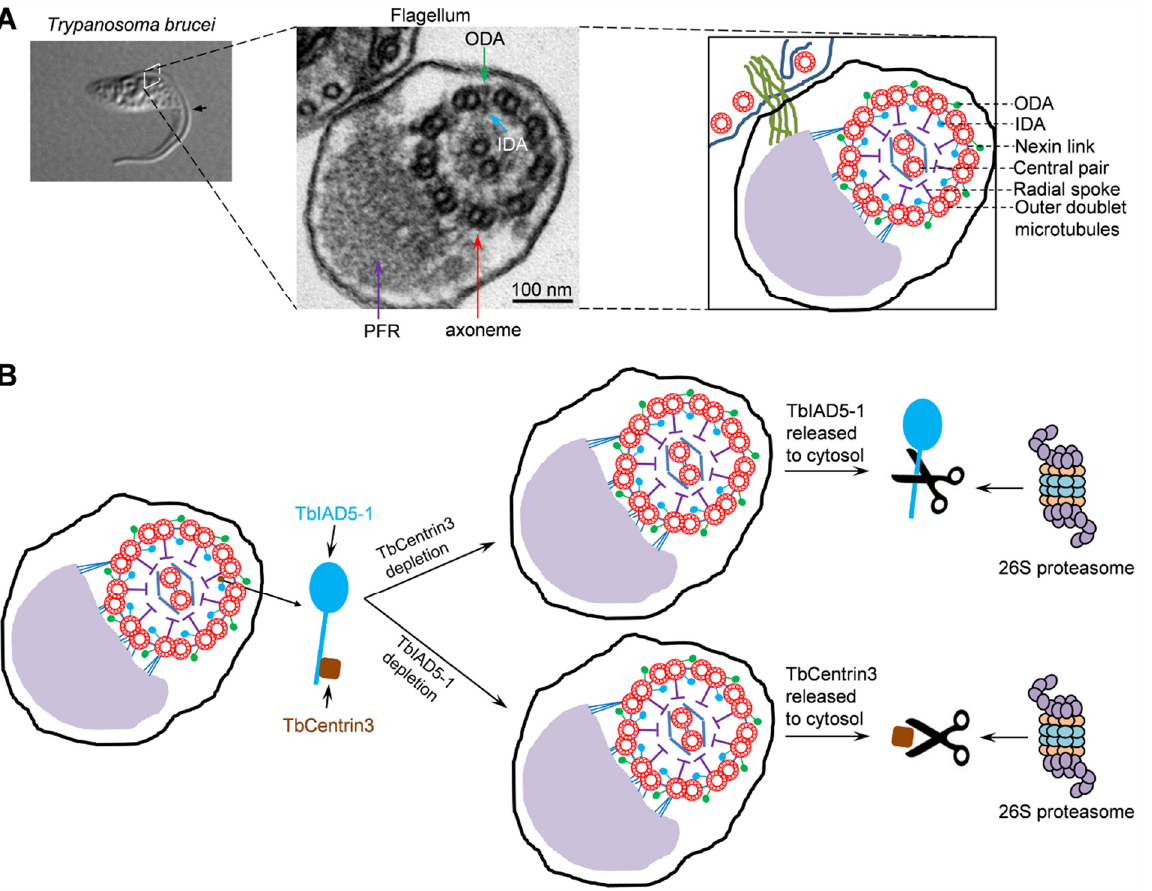
FIGURE 1: Role of TbCentrin3 in flagellar motility in trypanosomes. (A) The trypanosome flagellum and its axoneme structure. Shown on the left panel is a differential interference contrast (DIC) image of a procyclic cell of T. brucei with a single flagellum (arrow). The middle panel shows the transmission electron microscopy of a cross-section of the flagellum and the cell body to which the flagellum is attached. The paraflagellar rod (PFR), the axoneme, outer dynein arm (ODA), and inner dynein arm (IDA) are indicated. The right panel is a schematic representation of the micrograph shown in the middle panel. (B) Effect of TbCentrin3 depletion on the assembly and stability of TbIAD5-1 and vice versa. Note that only one IDA is labeled as the TbIAD5-1 - TbCentrin3 complex and that TbCentrin3 and TbIAD5-1 are not drawn to the same scale. The precise numbers of inner dynein arms containing TbCentrin3 and TbIAD5-1 are still unclear. In the absence of TbCen- trin3, newly synthesized TbIAD5-1 is not assembled to the axoneme and the old, axoneme-associated TbIAD5-1 is released to the cytosol, where it is degraded by the 26S proteasome. Conversely, in the absence of TbIAD5-1, new TbCentrin3 also fails to assemble to the axoneme and old TbCentrin3 is released from the axoneme to the cytosol, where it is degraded by the 26S